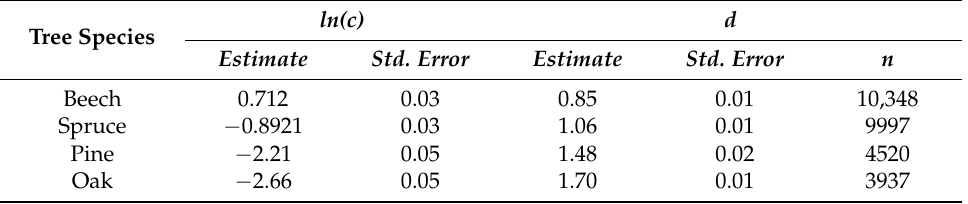
Table 4. Estimates of the crown projection area functions for European beech, Norway spruce,